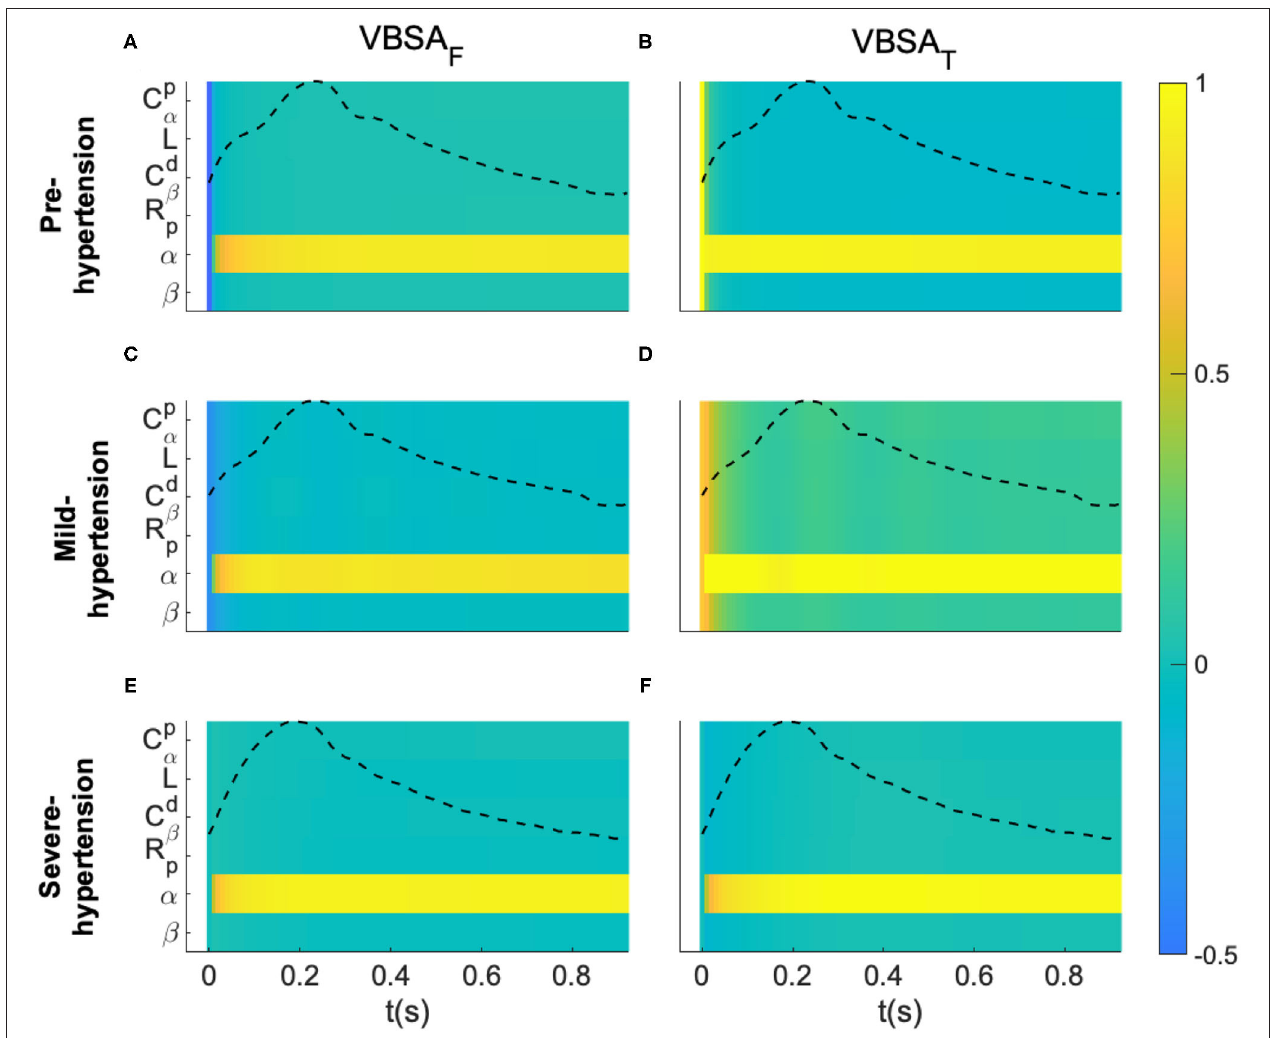
FIGURE 4 | Variance-based sensitivity analysis of the proposed fractional-order model. (A,C,E) Represent the first-order indices (VBSA F ) of the model’s parameters for a Pre-hypertensive, Mild-hypertensive and Severe-hypertensive subject, respectively. (B,D,F) Represent the total-order indices (VBSA T ) of the model’s parameters for a Pre-hypertensive, Mild-hypertensive and Severe-hypertensive subject, respectively. The variance based sensitivity indices were evaluated for each sample of the aortic proximal blood pressure over one cardiac